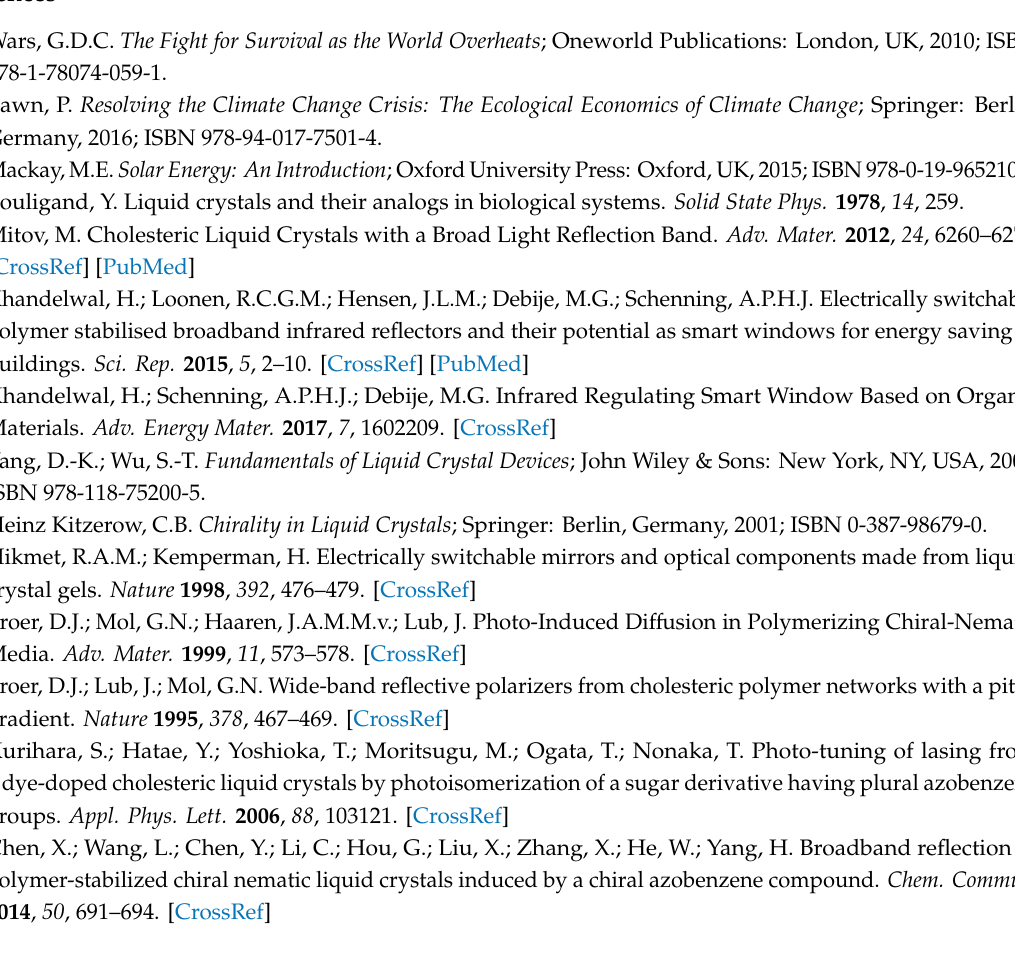
Figure S1: The reflection bandwidth of a cell with di ff erent thicknesses versus di ff erent in situ DC bias